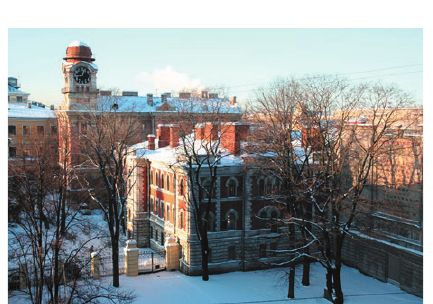
Figure 1. General view of the